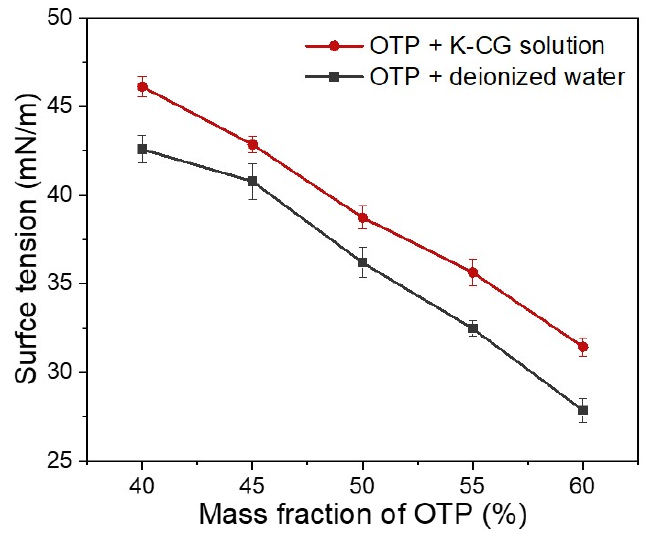
Figure 6. Surface tension in dispersing OTP in water and κ -CG